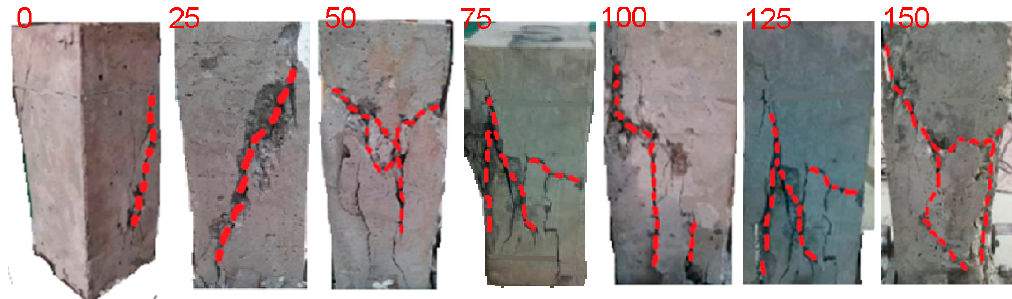
Figure 3. Failure modes of concrete under uniaxial compression with different numbers of freezing–thawing cycles.